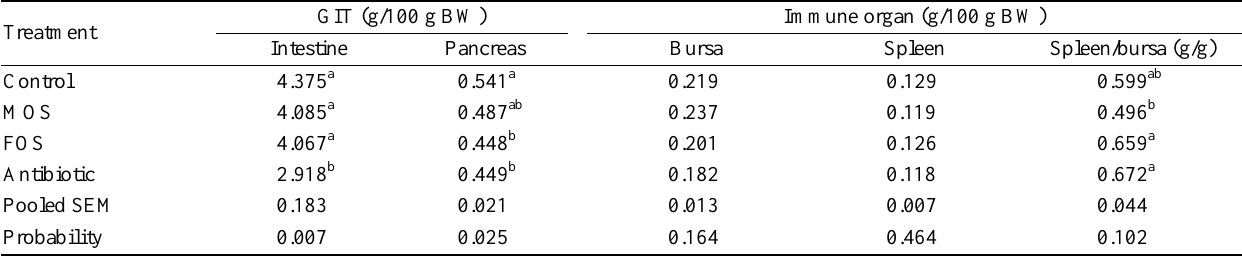
Table 3. Effects of oligosaccharides and antibiotics supplementation on gastrointestinal tract (GIT) and immune organ development at